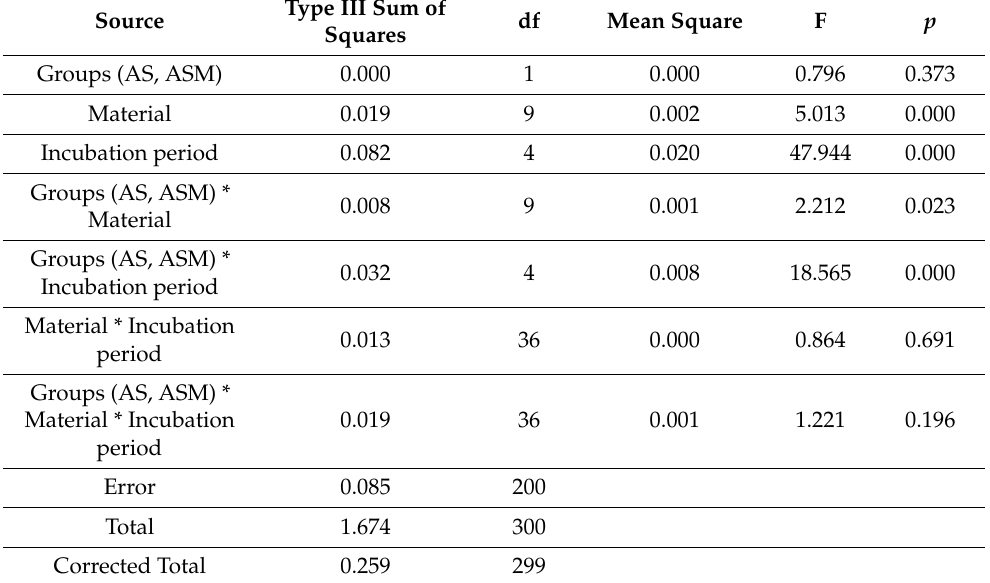
Table 2. Three-way analysis of variance (ANOVA) and Tukey’s post-hoc results for comparison of absorbant index values of the tested materials. * shows the interaction between the groups. Source